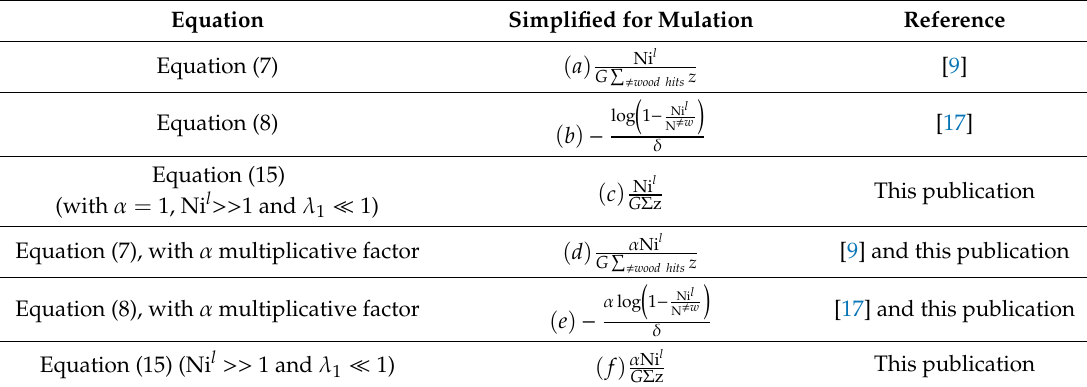
Table 1. Di ff erent estimators used to for numerical experiment described in Section 4.1. Equation Simplified for